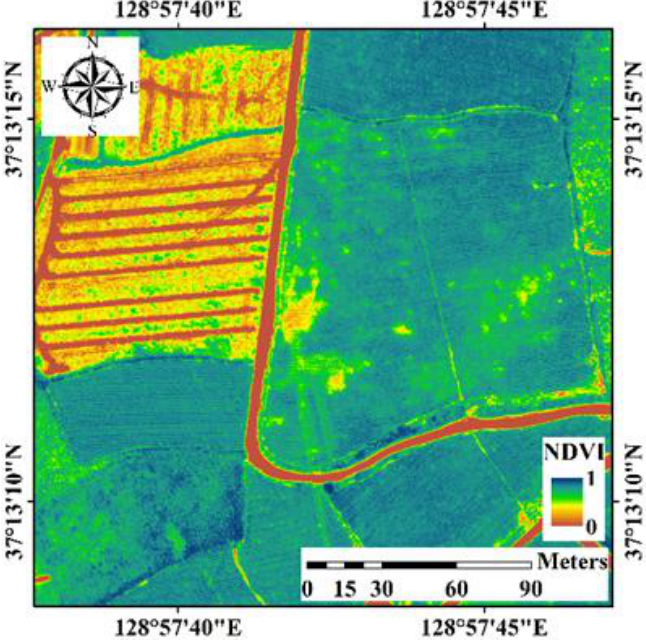
Figure 12. NDVI spatial distribution in images acquired by the UAV.